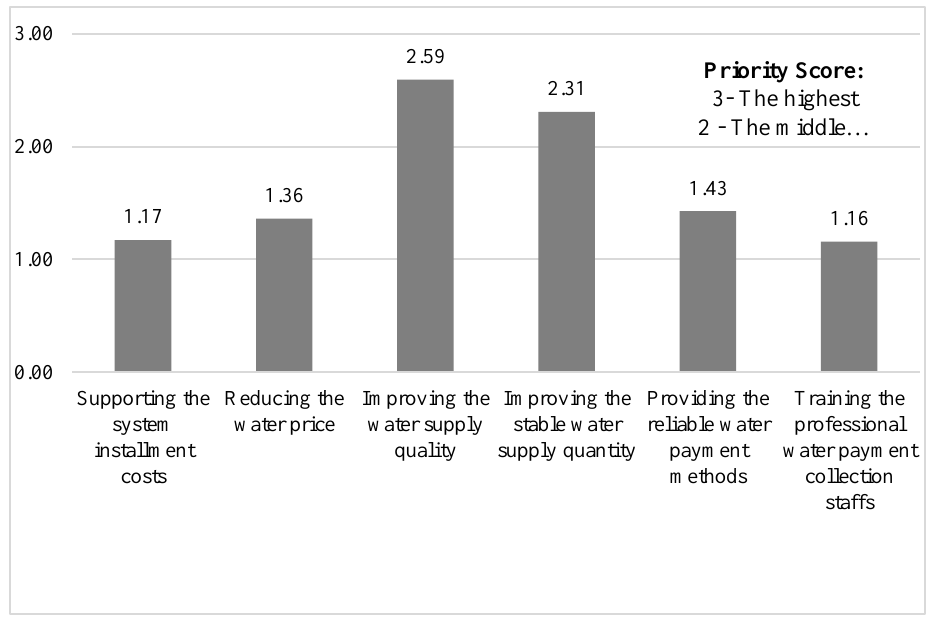
Figure 3. Prioritizing the tasks needed in order to improve HUDWSS.